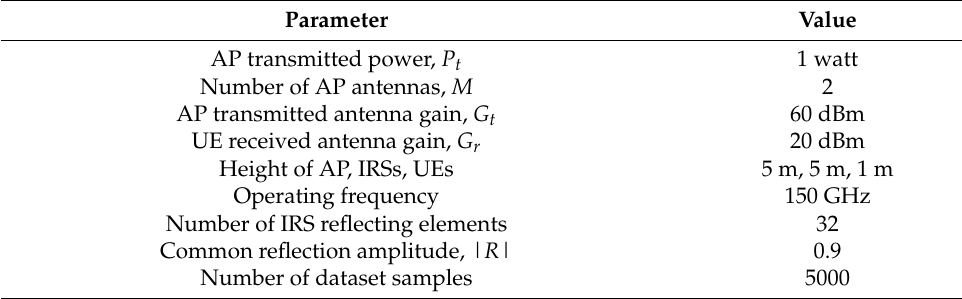
Table 1. Simulation parameters. Parameter Value AP transmitted power, P t 1